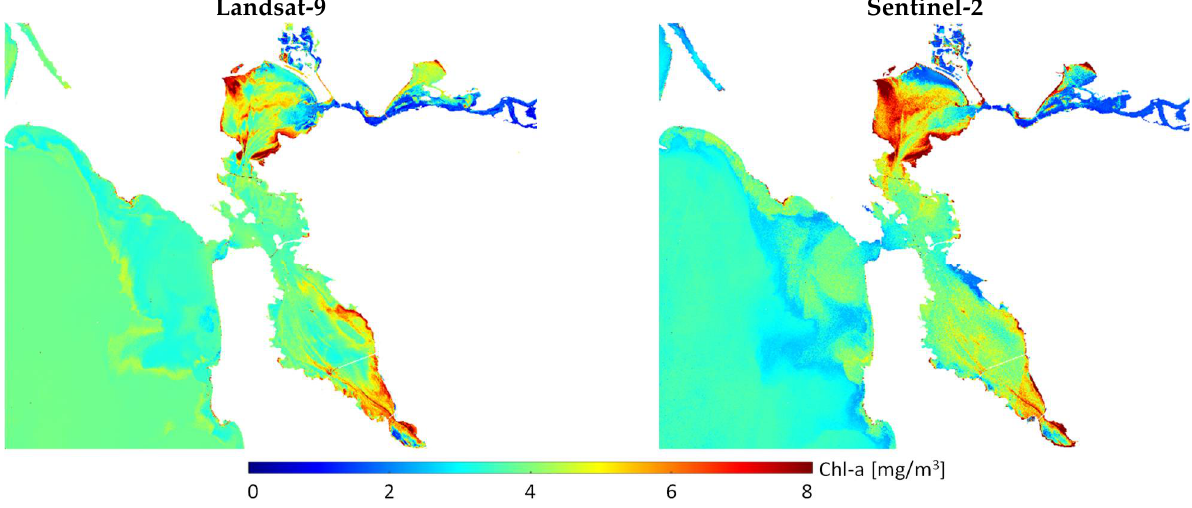
Figure 14. Chl-a maps derived from Landsat-9 and Sentinel-2 imagery in San Francisco Bay based on NN regression model.